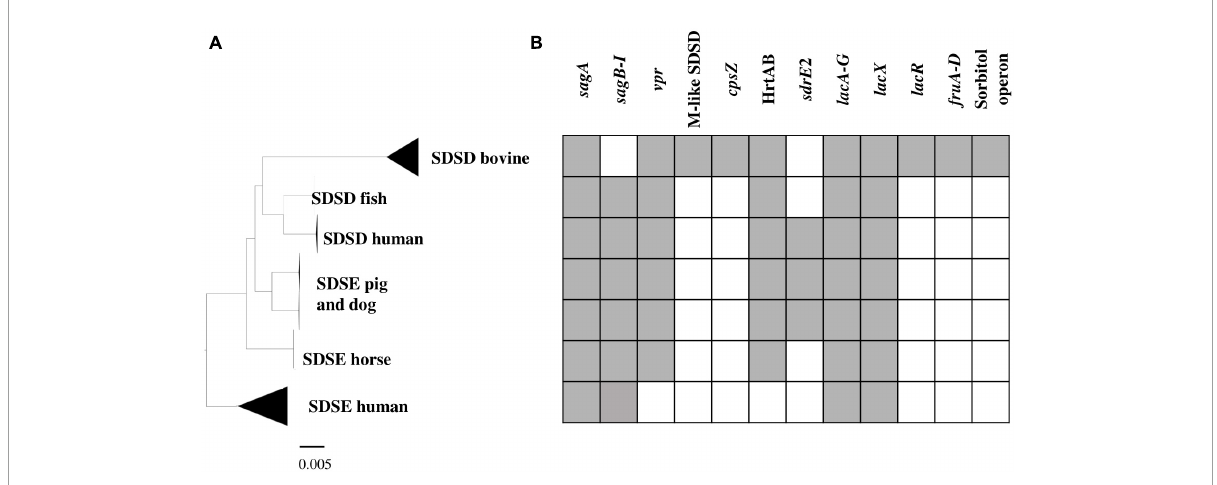
FIGURE5 Virulence and carbohydrate metabolism profiles of the 106 S. dysgalactiae isolates. (A) Phylogenetic analysis of the S. dysgalactiae single-copy core genome as in Figure 2 . (B) Graphic representation of the presence (gray) and absence (white) of the identified relevant gene clusters in the S. dysgalactiae genomes in this study. sagA to sagI – Streptolysin (SLS) operon; vpr gene – C5a peptidase ; M protein-like (SDSD); cpsZ gene – Emm-like cell surface protein; sdrE2 – adhesin; HrtAB – Heme efflux system; lacA to G, lacX and lacR genes – lactose metabolization